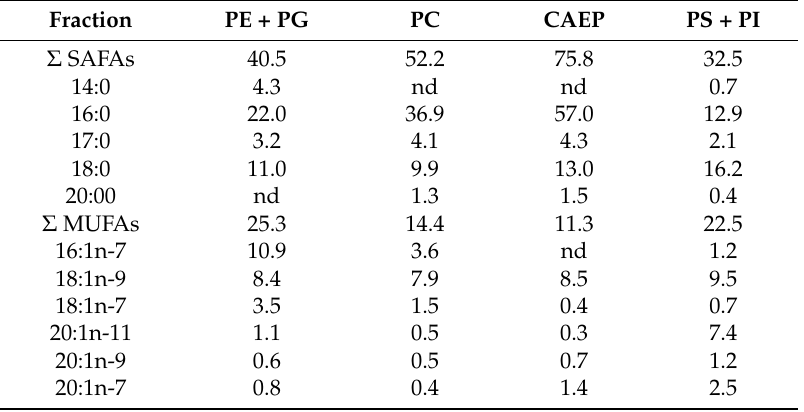
Table 3. Fatty acid composition (% of each type phospholipid) of